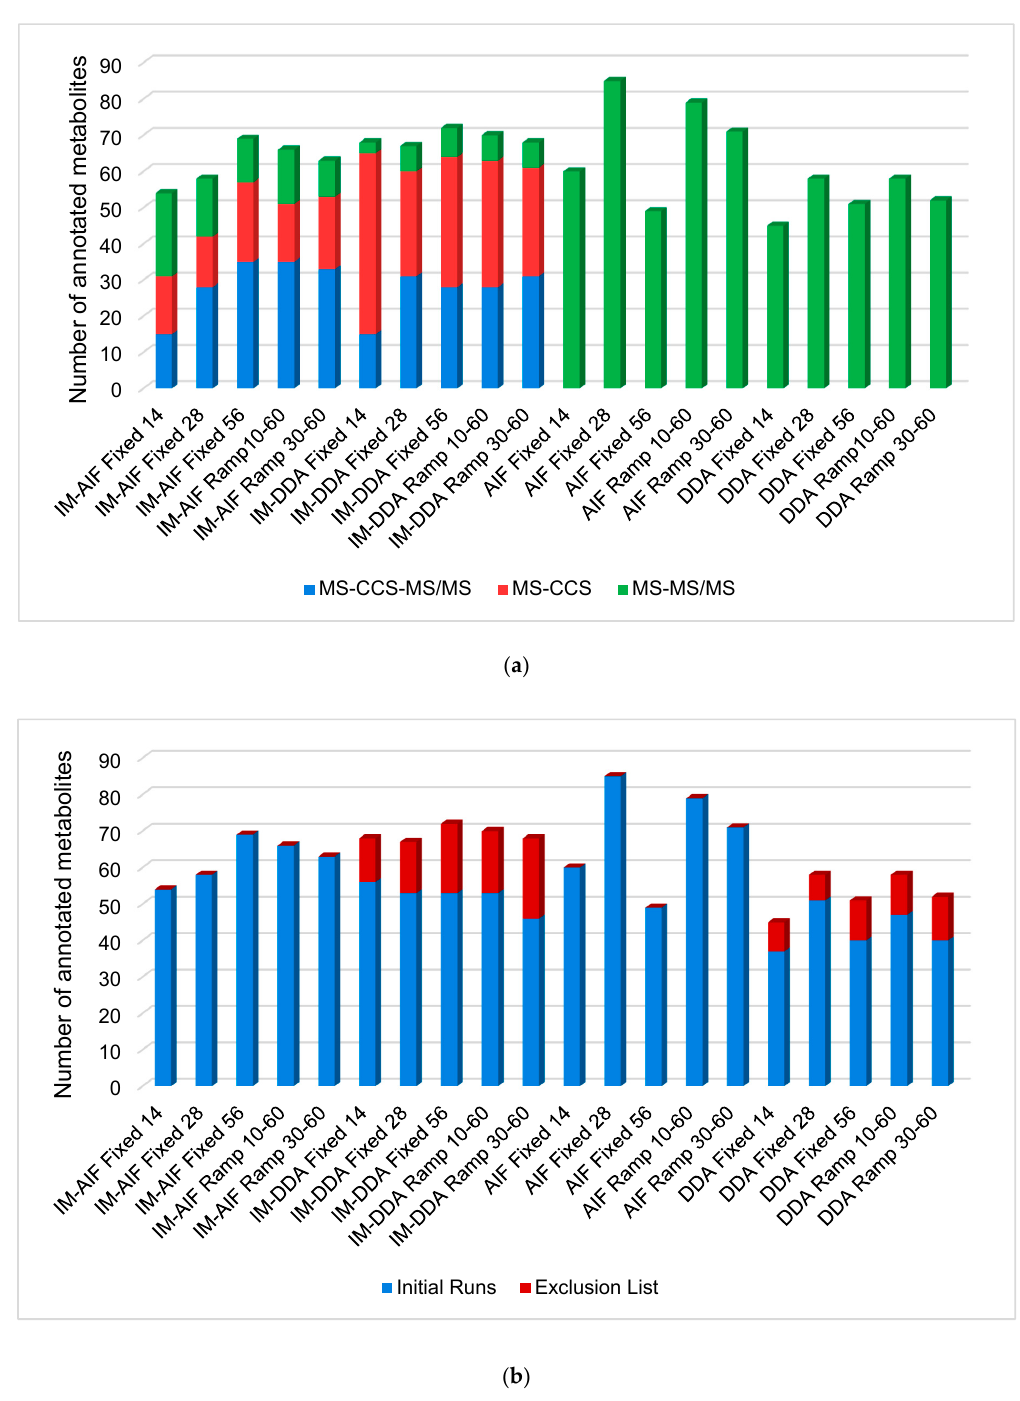
Figure 1. Overall unambiguous metabolite annotations ( a ) made by accurate mass- TW CCS N2 -MS / MS (blue), accurate mass- TW CCS N2 (red) and accurate mass-MS / MS (green); ( b ) made during the initial runs (blue) and after the exclusion list runs (red).